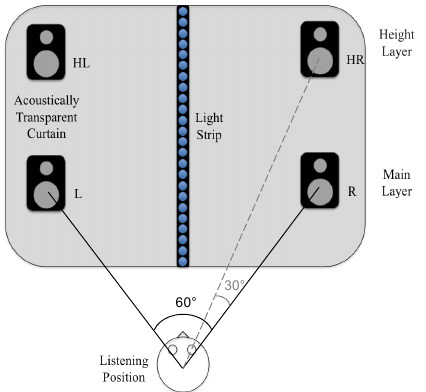
Figure 1. Loudspeaker setup used for the listening test. The main layer loudspeakers are configured with the standard 60 ◦ subtended angle from the listening position. The distance between the listener and each of the main layer speakers was 2 m. The height layer loudspeakers are placed right above the main layer ones, with 30 ◦ elevation from the listening position, based on the Auro-3D configuration